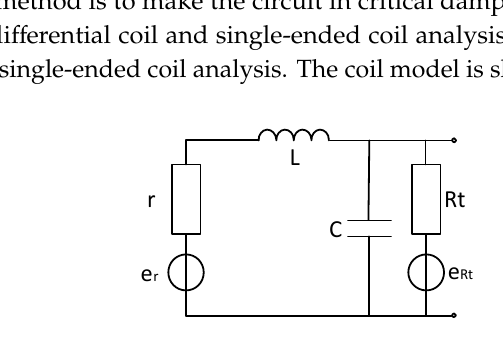
Figure 6. Air-coil model with matching resistor.